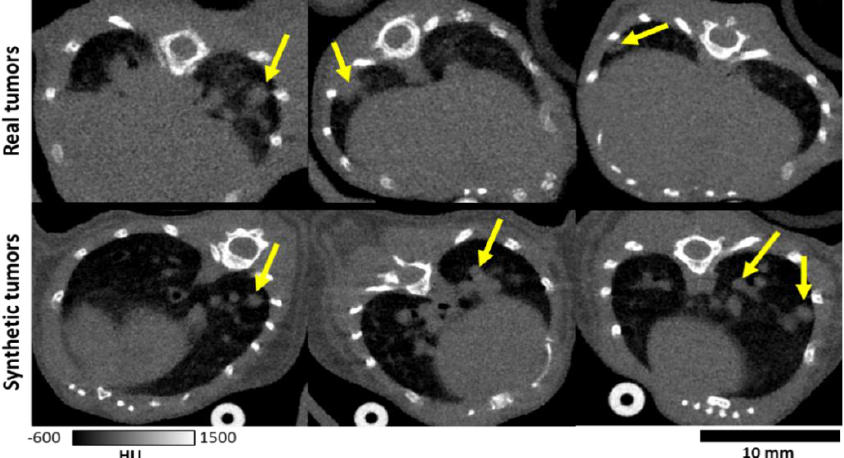
Figure 2. Diagram showing the generation of simulated lung tumors. (1) A scan of a healthy mouse is used as the base. (2) Tumors are added to empty volumes which are projected into the same space as the original projections. (3) The tumor is added and the lung subtracted from the original projections. (4) The reconstruction with lung tumors is performed via FDK followed by bilateral filtration (BF). Figure 3. Comparison of real and simulated tumors. Tumors are marked with yellow arrows. The simulated tumors are shown to contain similar sizes and textures as the real tumors.